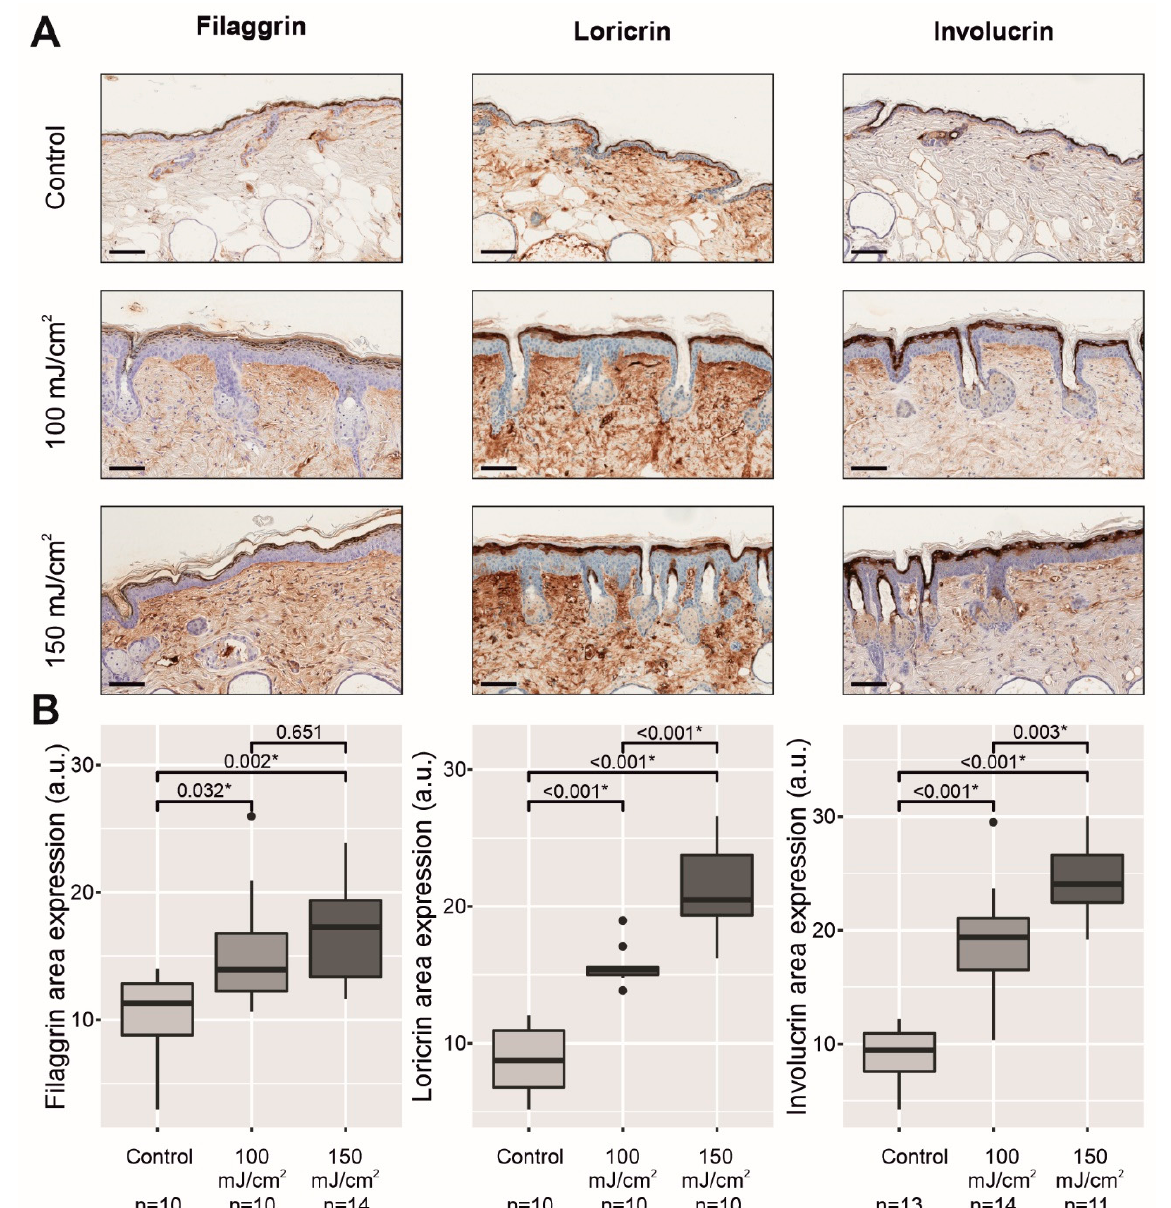
Figure 3. Comparative histology of nonirradiated skin with respect to UV-B-irradiated skin with CFC of the mouse back at the end of the experiment (14 weeks after initiating UV-B irradiation). From left to right, filaggrin, loricrin, and involucrin immunostaining in the upper epidermis. The scale bar represents 100 µm ( A ). Below, there is a quantitative analysis of the immunostaining for each differentiation marker using ImageJ software and expressed in arbitrary units (a.u.) ( B ). * p < 0.05.